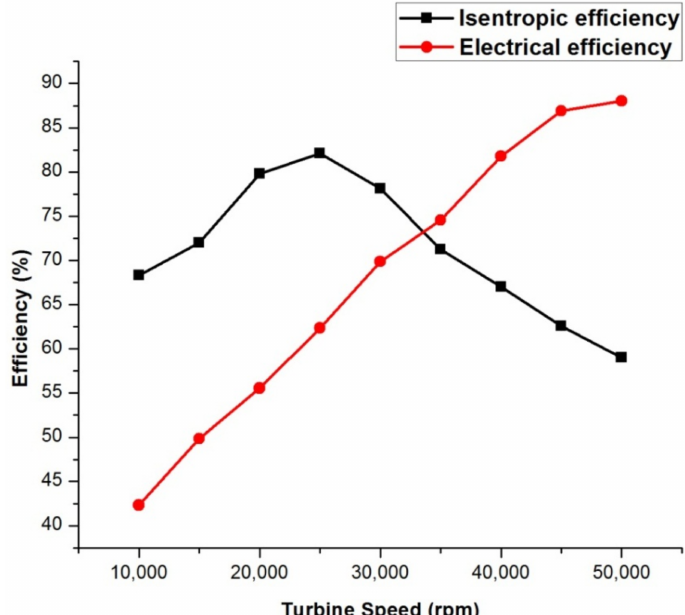
Figure 7. Variation of turbine speed on the isentropic and electrical efficiency.